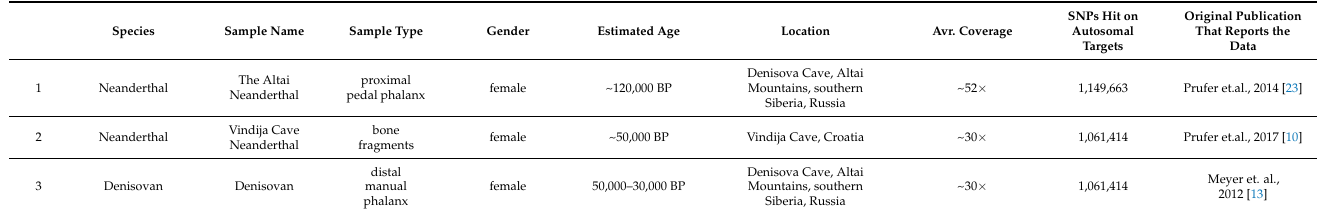
Table 1. Neanderthal and Denisovan genome-wide data analyzed in this